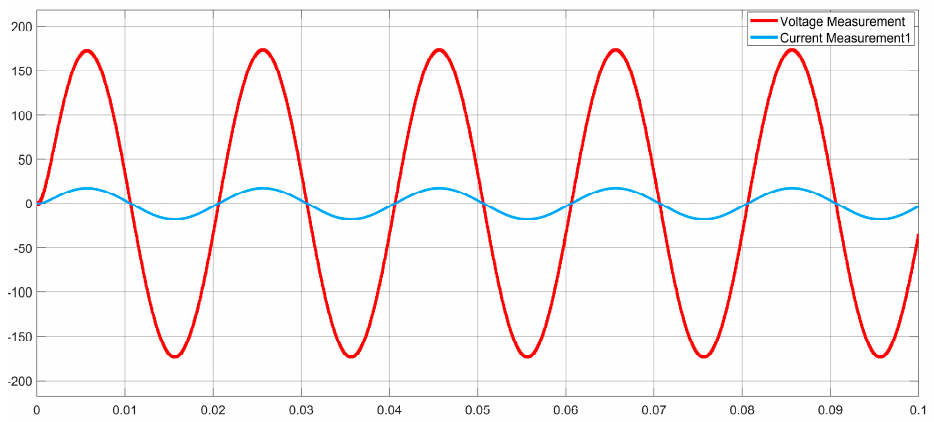
Figure 15. Simulated THD of the output voltage under SPWM.